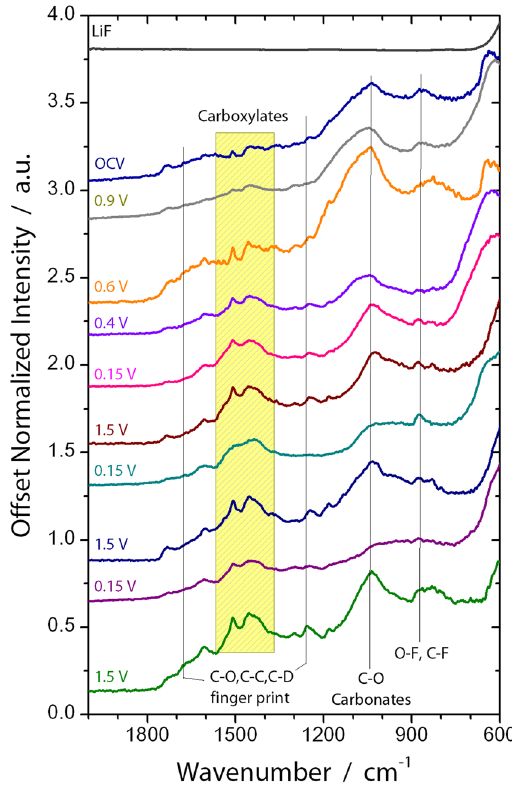
Figure 8. ATR-IR spectra of exact witness samples investigated via XPS.